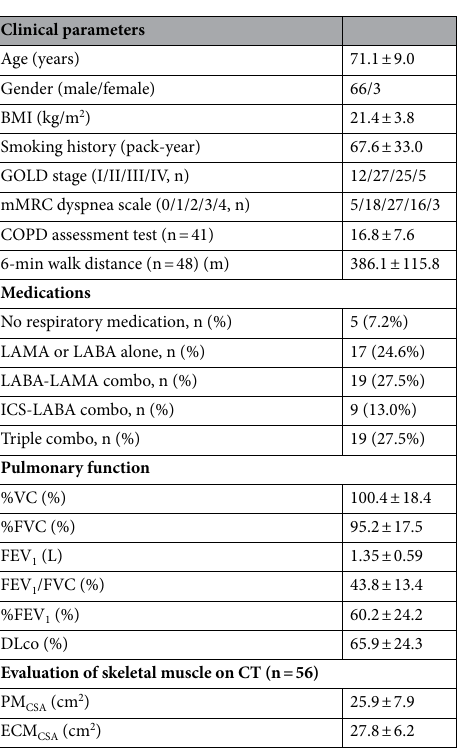
Table 1. Demographics of the study participants (n = 69). BMI body mass index, GOLD global initiative for chronic obstructive lung disease, mMRC modified medical research council, COPD chronic obstructive pulmonary disease, LAMA long-acting muscarinic antagonist, LABA long acting β 2 adrenergic agonist, ICS inhaled corticosteroid, VC vital capacity, FVC forced vital capacity, FEV 1 forced expiratory volume in 1 s, DLco diffusing capacity of lung for carbon monoxide, PM CSA cross-sectional area of pectoralis muscles, ECM CSA cross-sectional area of erector spinae muscles. Data are presented as mean ± standard